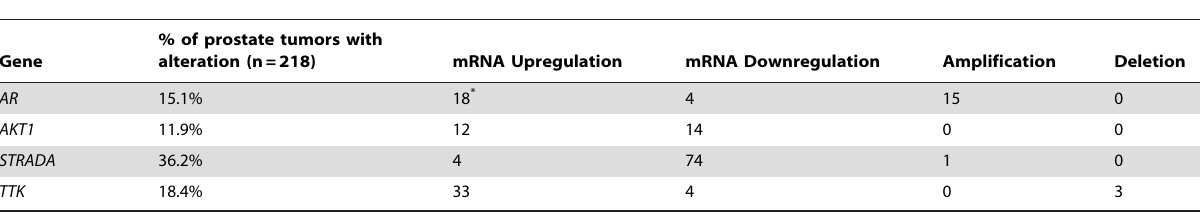
*4 of the samples with upregulated AR mRNA also had AR amplification.